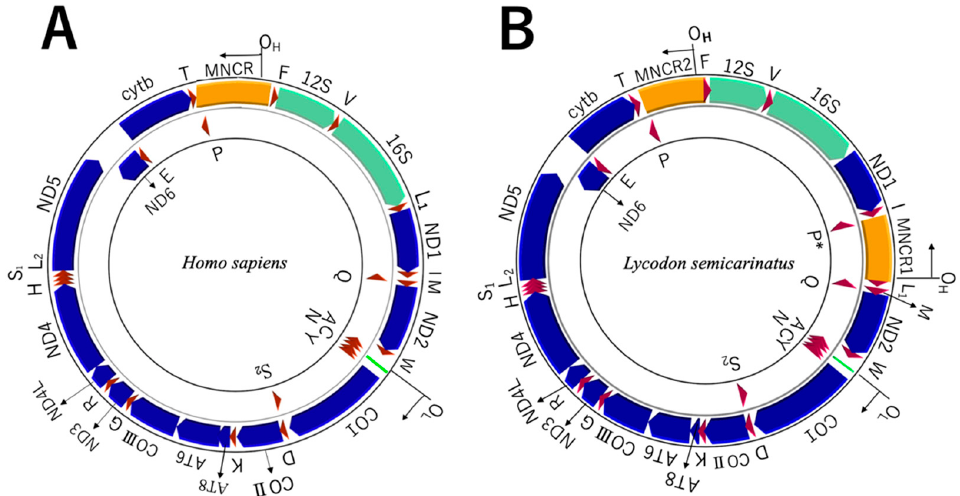
Figure 1. Gene arrangements of mitochondrial genomes of ( A ) the human [1] and ( B ) the colubrid snake Lycodon semicarinatus [12]. Genes encoded by the heavy strand are shown in the outer circle while those encoded by the light strand are shown in the inner circle. Abbreviations for genes are: 12S and 16S, 12S and 16S rRNA genes; CO I–III, cytochrome oxidase subunits I–III genes; ND1–6 and 4L, NADH dehydrogenase subunits 1–6 and 4L genes; AT8 and AT6, ATPase subunits 8 and 6 genes; and cytb, cytochrome b gene. Transfer RNA genes are denoted by one letter of the corresponding amino acids. L 1 , L 2 , S 1 , S 2 and p* represent genes for tRNA Leu (UUR), tRNA Leu (CUN), tRNA Ser (AGY), tRNA Ser (UCN), and a pseudogene for tRNA Pro , respectively. Abbreviations for noncoding features are: MNCR, major noncoding region; O H , heavy-strand replication origin; and O L , light-strand replication origin.